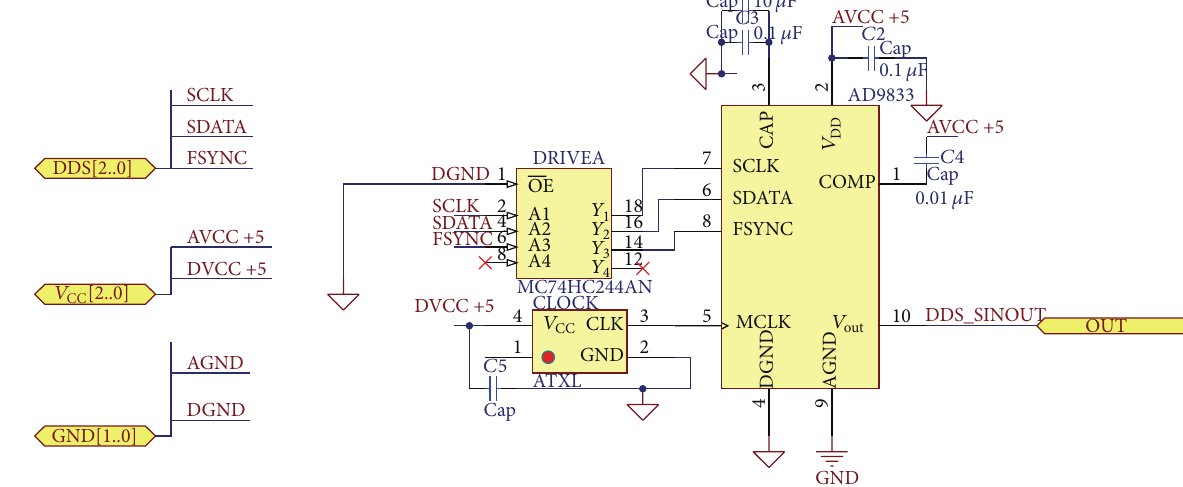
Figure 6: The keyboard circuit.